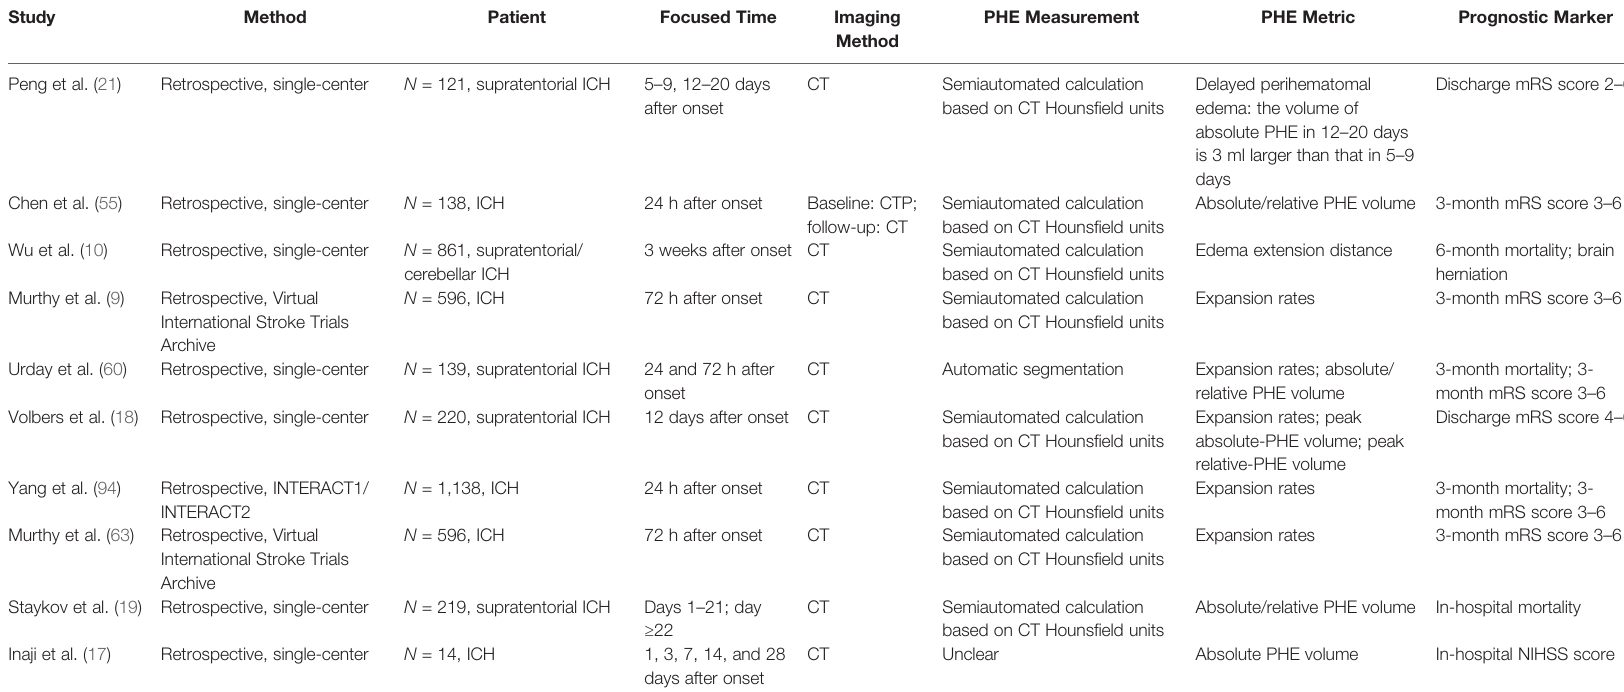
TABLE 1 | Summary of prognostic research of PHE — the PHE was associated with poor ICH